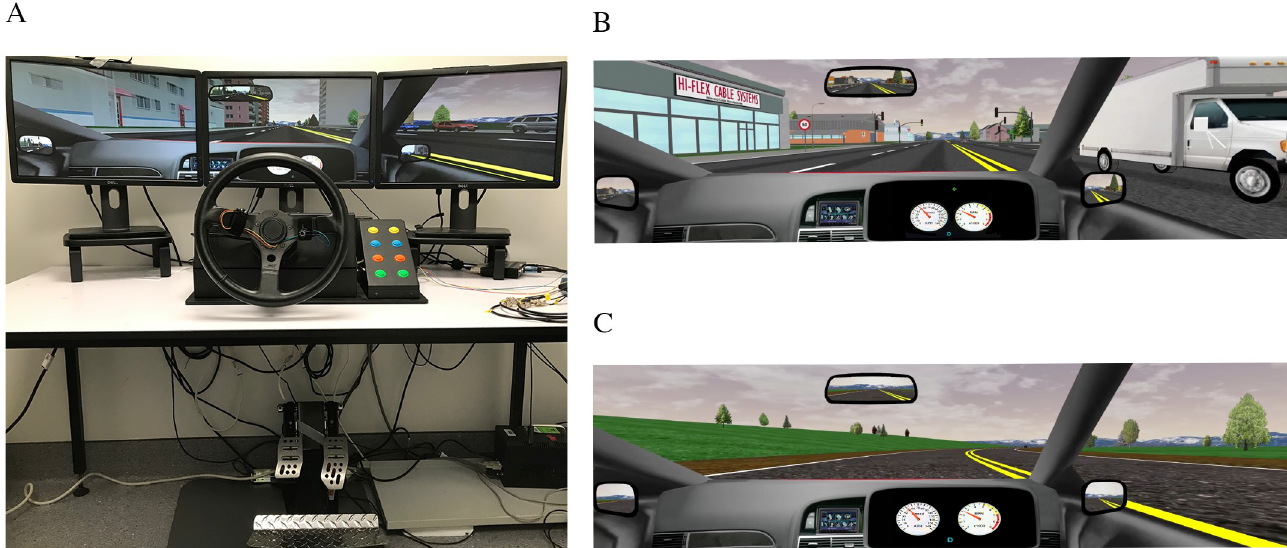
Fig 1. Driving simulator equipment configuration. A. An overview of the simulator composed of three-monitor display positioned approximately 90 cm from the participant, steering system, and pedals. B. An example of the high cognitive load scenario in an urban environment with a high density of buildings and traffic. C. An example of the low cognitive load scenario in a rural environment with a low density of buildings and traffic.